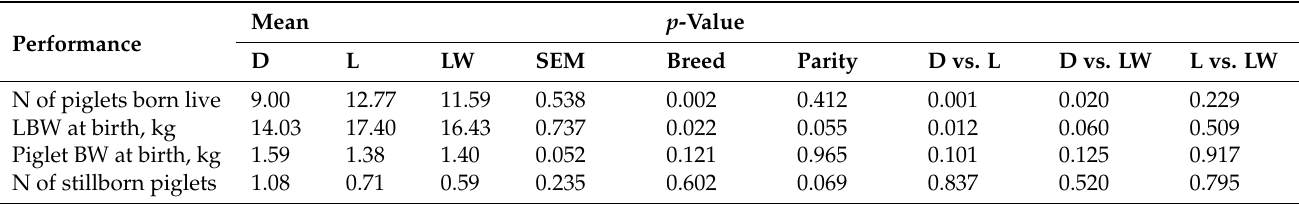
Table 1. The effect of breed and parity on sow performance at